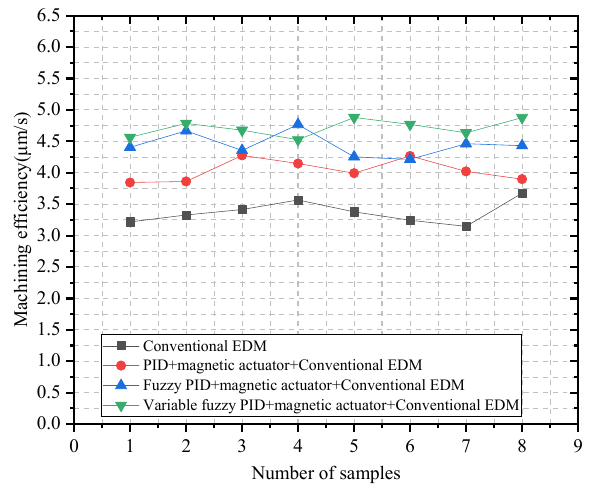
Figure 14. Comparison of micro-EDM efficiency.